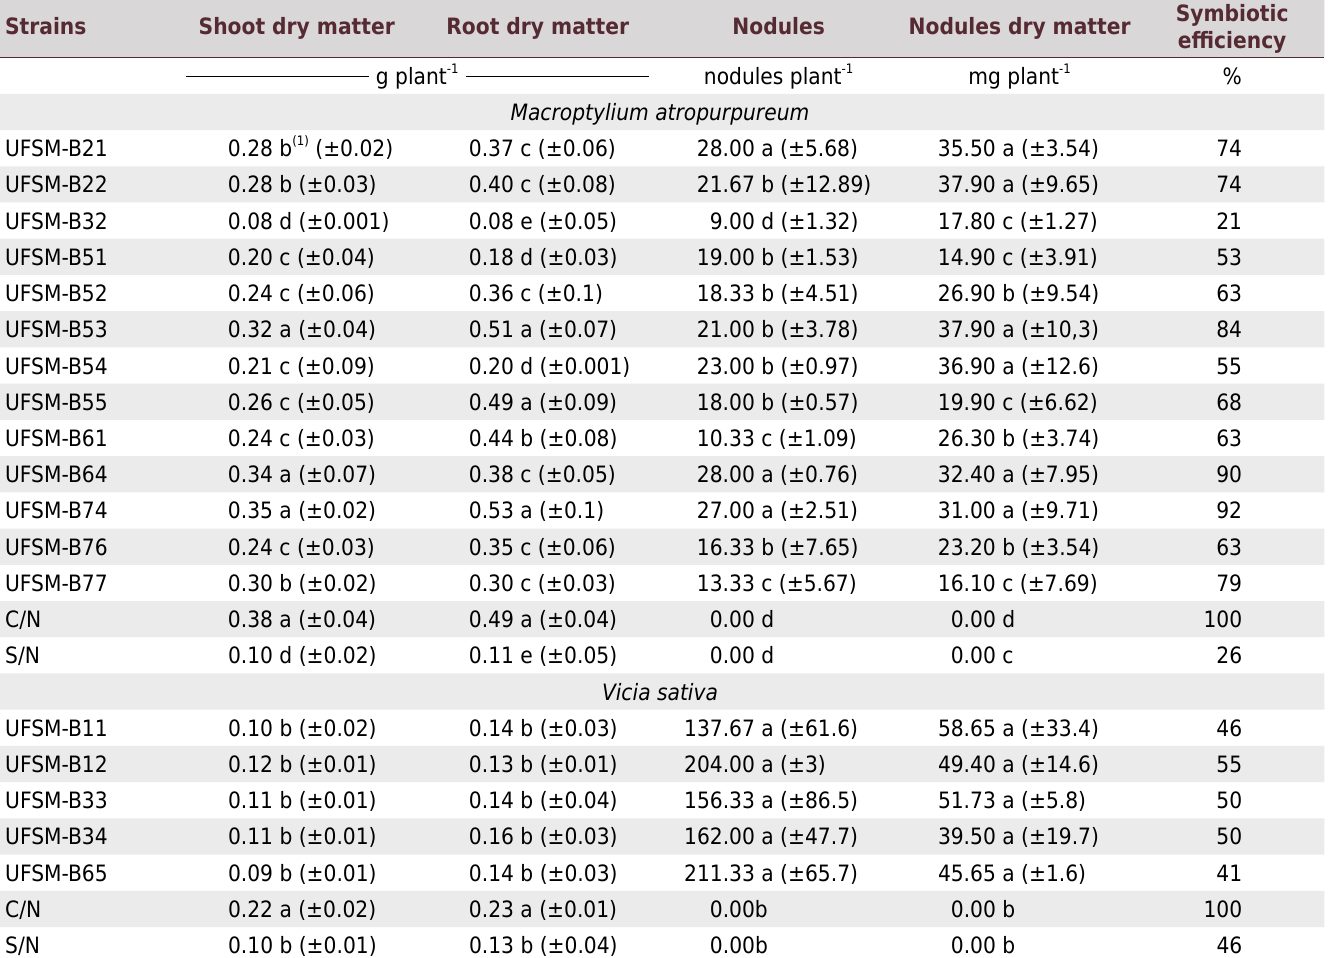
Table 5. Influence of the tested strains on shoot dry matter, root dry matter, number of nodules, nodule dry matter, and symbiotic efficiency (SE) of Atropurpureum macroptylium and Vicia sativa and two controls, C/N (with mineral nitrogen) and S/N (without mineral N) Strains Shoot dry matter Root dry